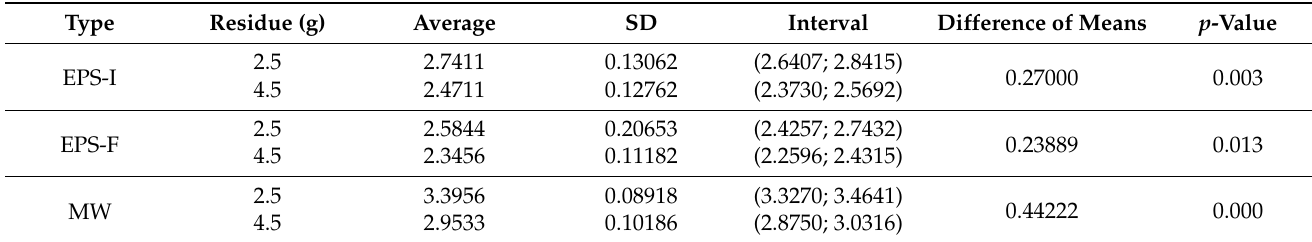
Table 8. Comparison for compressive strength (MPa) between lime mortars with incorporation of thermal insulation residues.